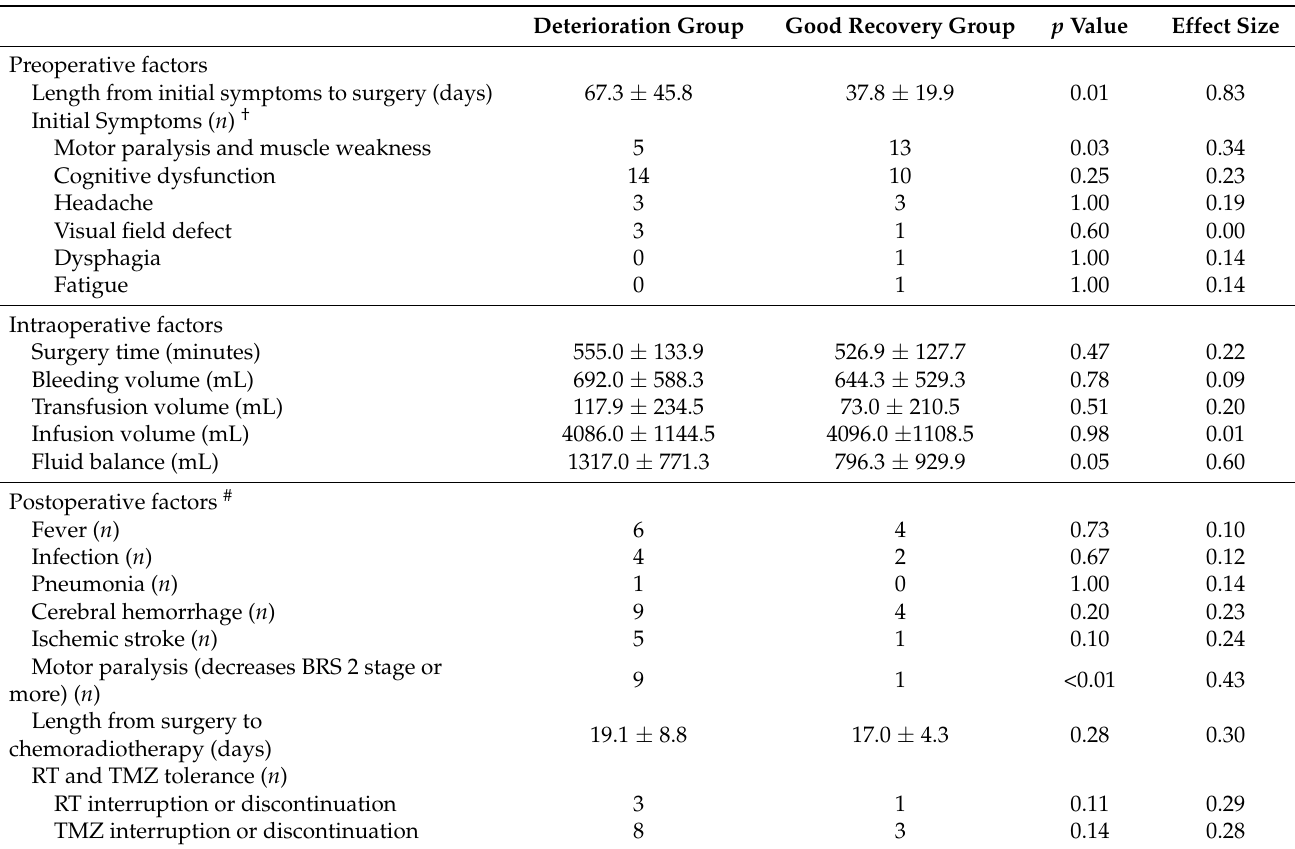
Table 2. Comparison of the deterioration and good recovery groups based on pre-, intra-, and post-operative